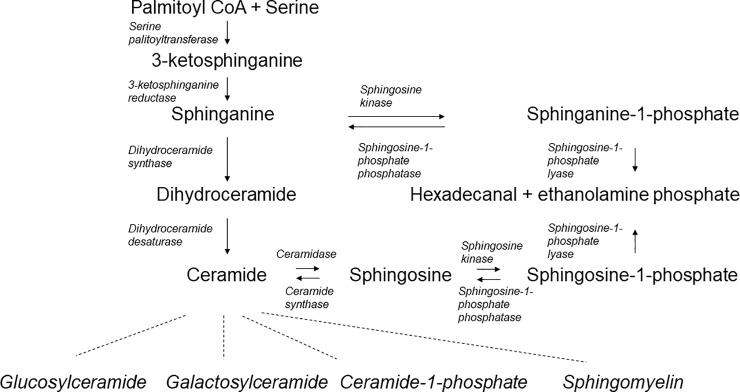
Overview of core sphingolipid pathways.The sphingolipids analysed in our study are highly interconnected and play central roles in sphingolipid metabolism.